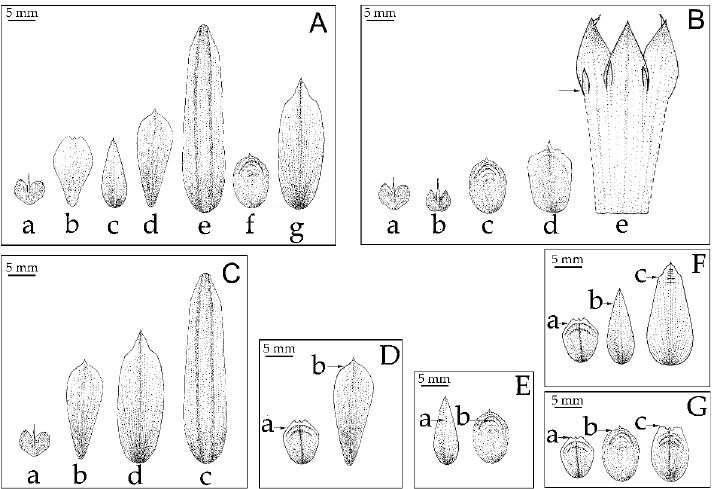
Figure 9. Median inner tepal morphologies comparison and character state between Musaceae (character no. 9–15), ( A ) shape of free median inner tepal: ( a ) tricuspidate; ( b ) obovate; ( c ) oval- lanceolate; ( d ) oblanceolate; ( e ) oblong; ( f ) elliptic; ( g ) ovate, ( B ) base of median inner tepal: ( a ) acute; ( b ) sub-cordate; ( c ) obtuse; ( d ) truncate; ( e ) adnate with perianth tube ( C ) apex of free median inner tepal: ( a ) cuspidate; ( b ) acuminate; ( c ) attenuate; ( a ) subobtuse ( D ) wings on shoulder of free median inner tepal: ( a ) wing present; ( b ) wing absent, ( E ) present of wrinkle on free median inner tepal: ( a ) absent; ( b ) present, ( F ) margin on shoulder of free median inner tepal: ( a ) dentate; ( b ) entire; ( c ) repand, ( G ) apex of shoulder of free tepal: ( a ) acute; ( b ) round; ( c ) truncate.